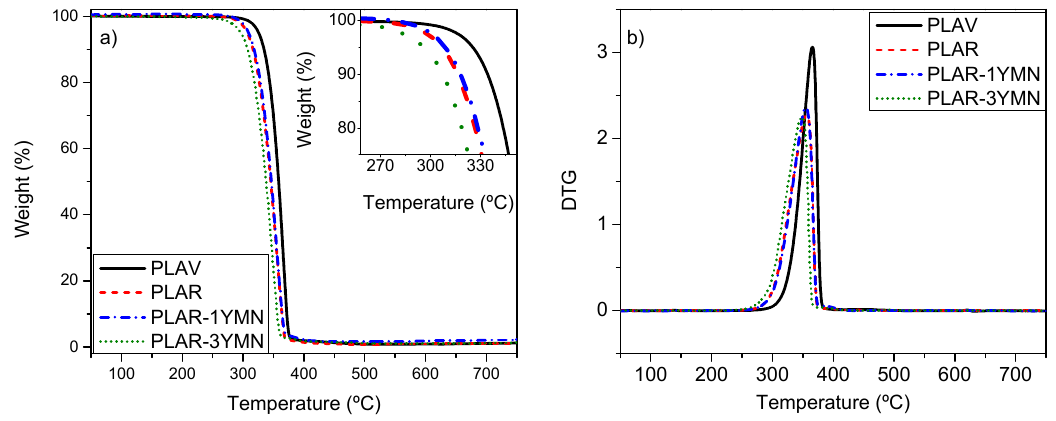
Figure 8. Dynamic ( a ) TGA and ( b ) DTGA curves of binary PLA nanocomposite films.